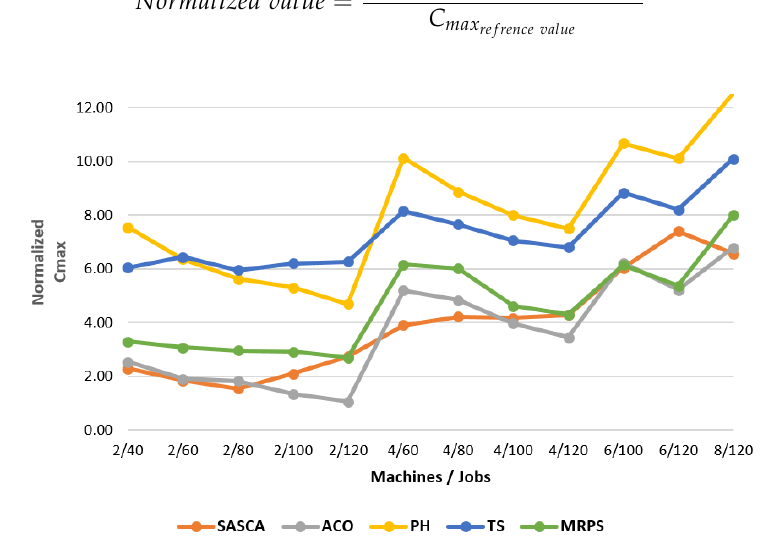
Figure 2. Normalized C max to show the performances of all